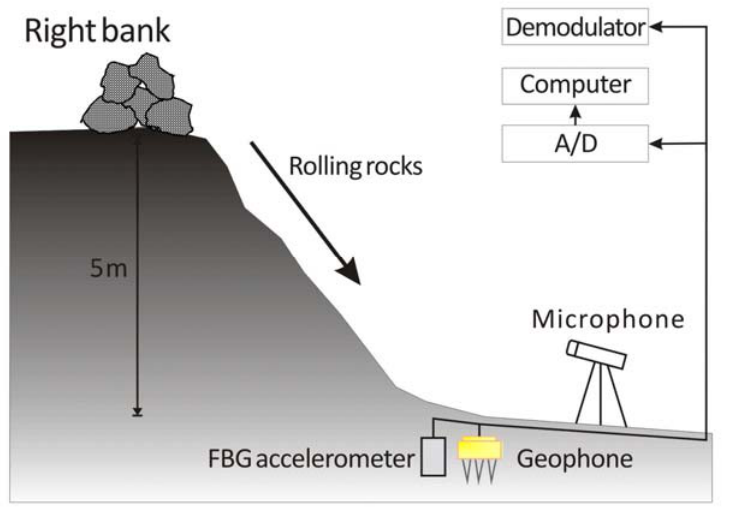
Figure 5. Field test for comparing the performance of the proposed fiber-optic sensing system with those of conventional systems involving a geophone or a